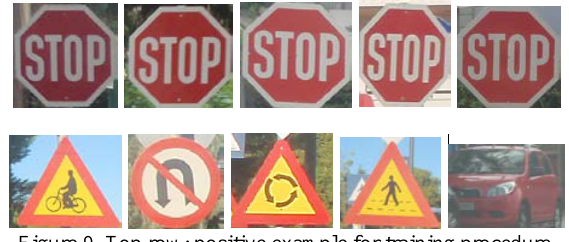
Figure 9. Top row: positive example for training procedure, Bottom row: Negative examples for training procedure